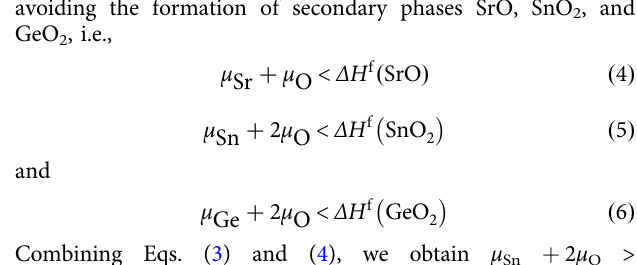
lower than that of B-site alloy only in the upper right corner of the μ Sn vs. μ O diagram, a region where SrSnO 3 itself is unstable and SnO 2 is favorable to